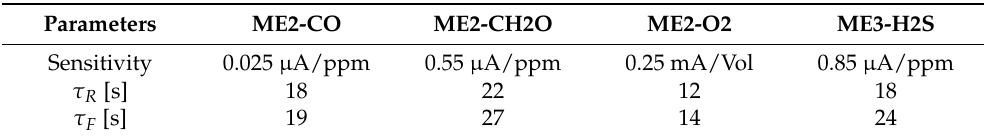
Table 3. Parameters of the electrochemical gas sensors extracted from the transient characteristics reported above.